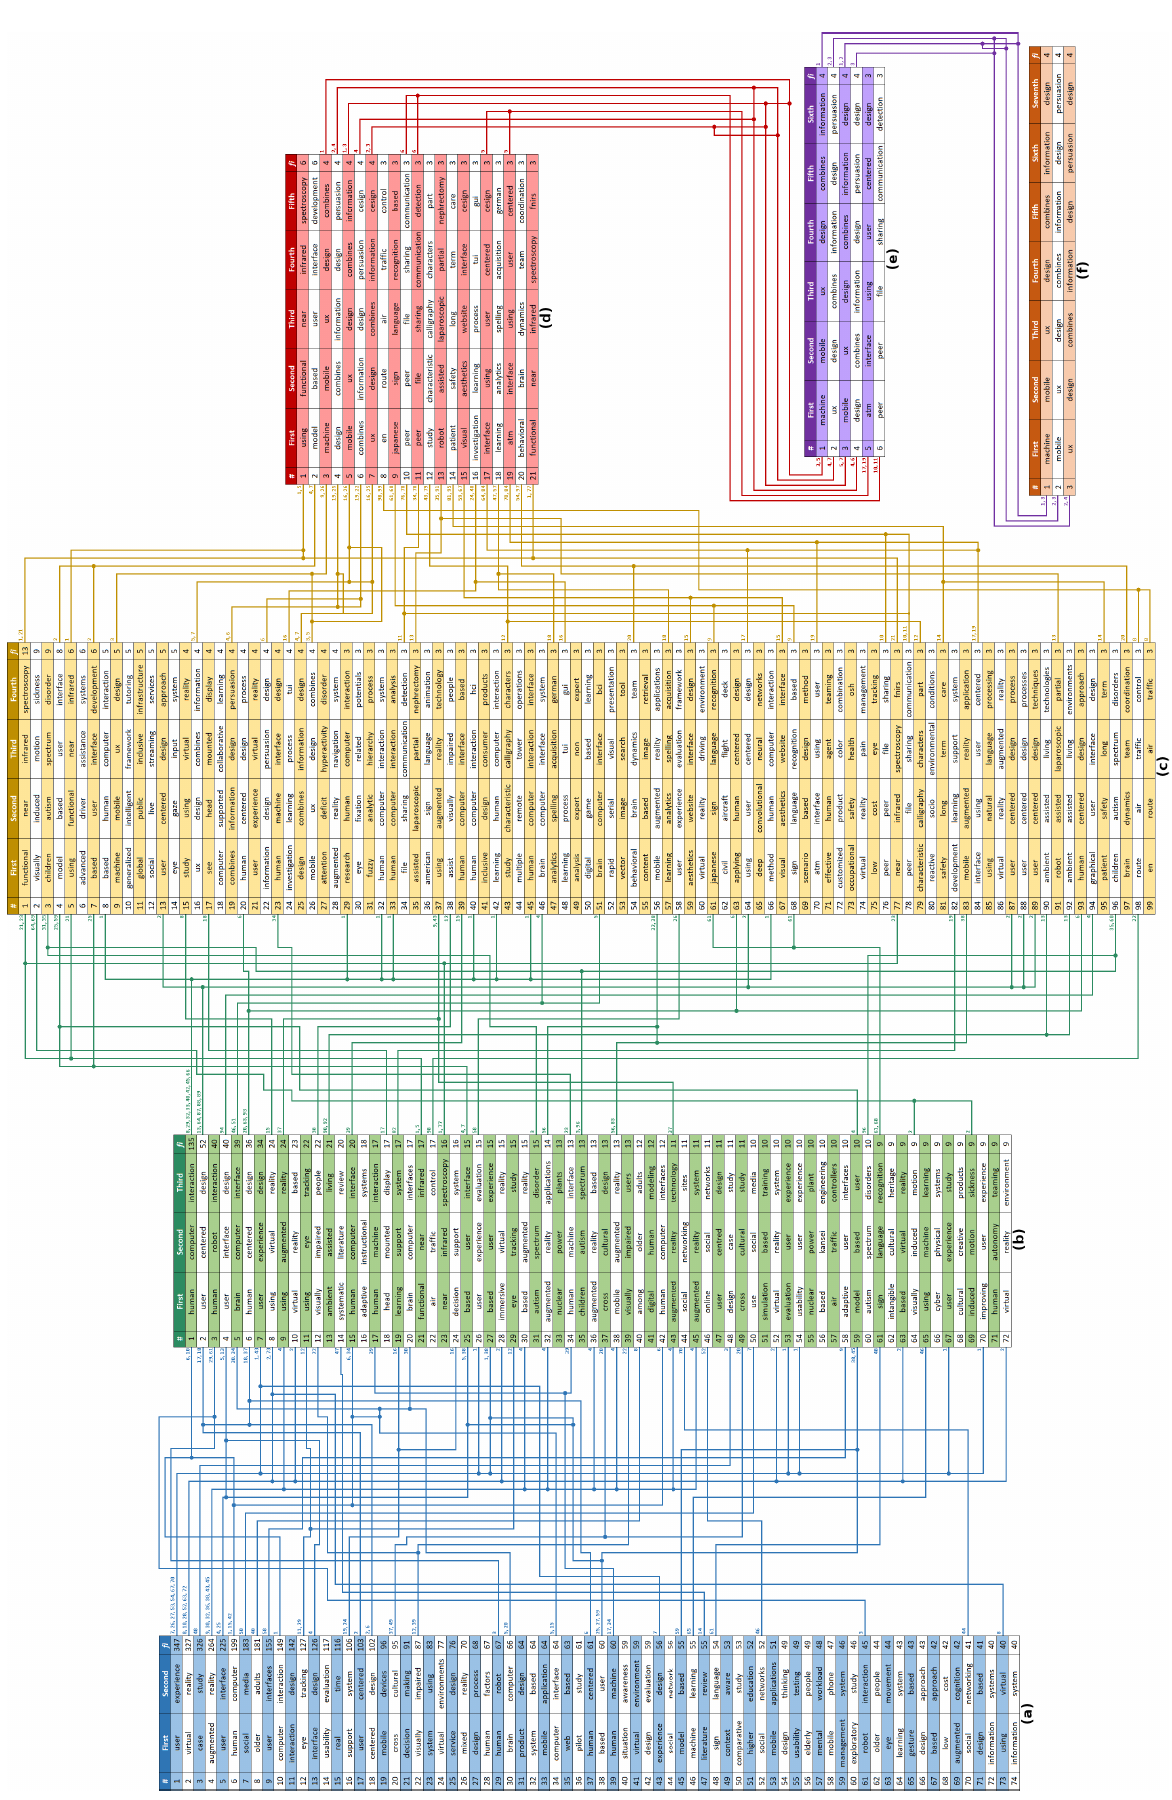
Figure 6. n -grams correlation network from HCII: (a) bigram; (b) trigram; (c) quadgram; (d) pentgram; (e) hexagram; and (f) heptagram